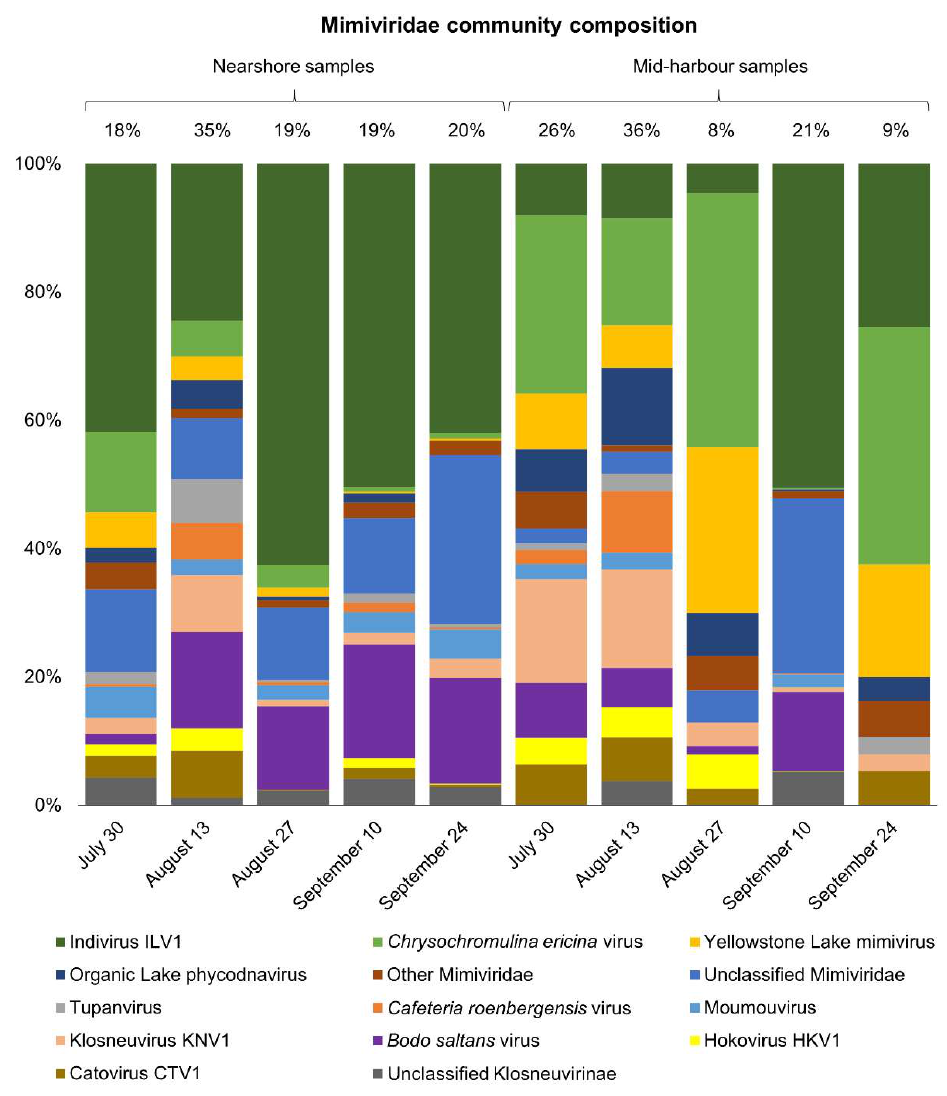
Figure 4. Mimiviridae community composition at the nearshore and mid-harbour sites from 30 July to 24 September. Numbers above bars are percentages of the total virus community that the entire bar represents.